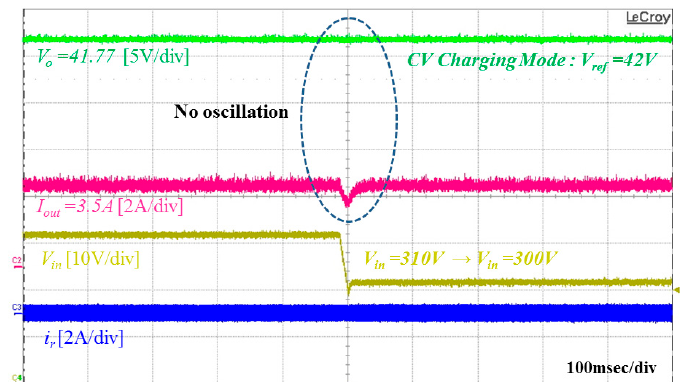
Figure 14. Experimental waveform of the proposed compensator with the CC mode under step- change of the input voltage.